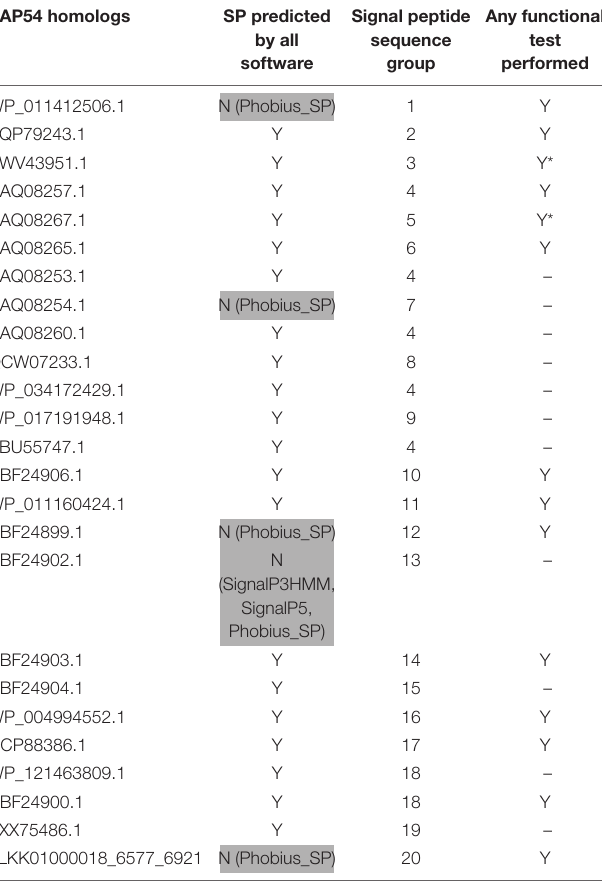
TABLE 2 | SAP11 homologs used in this study. SAP11 homologs SP predicted